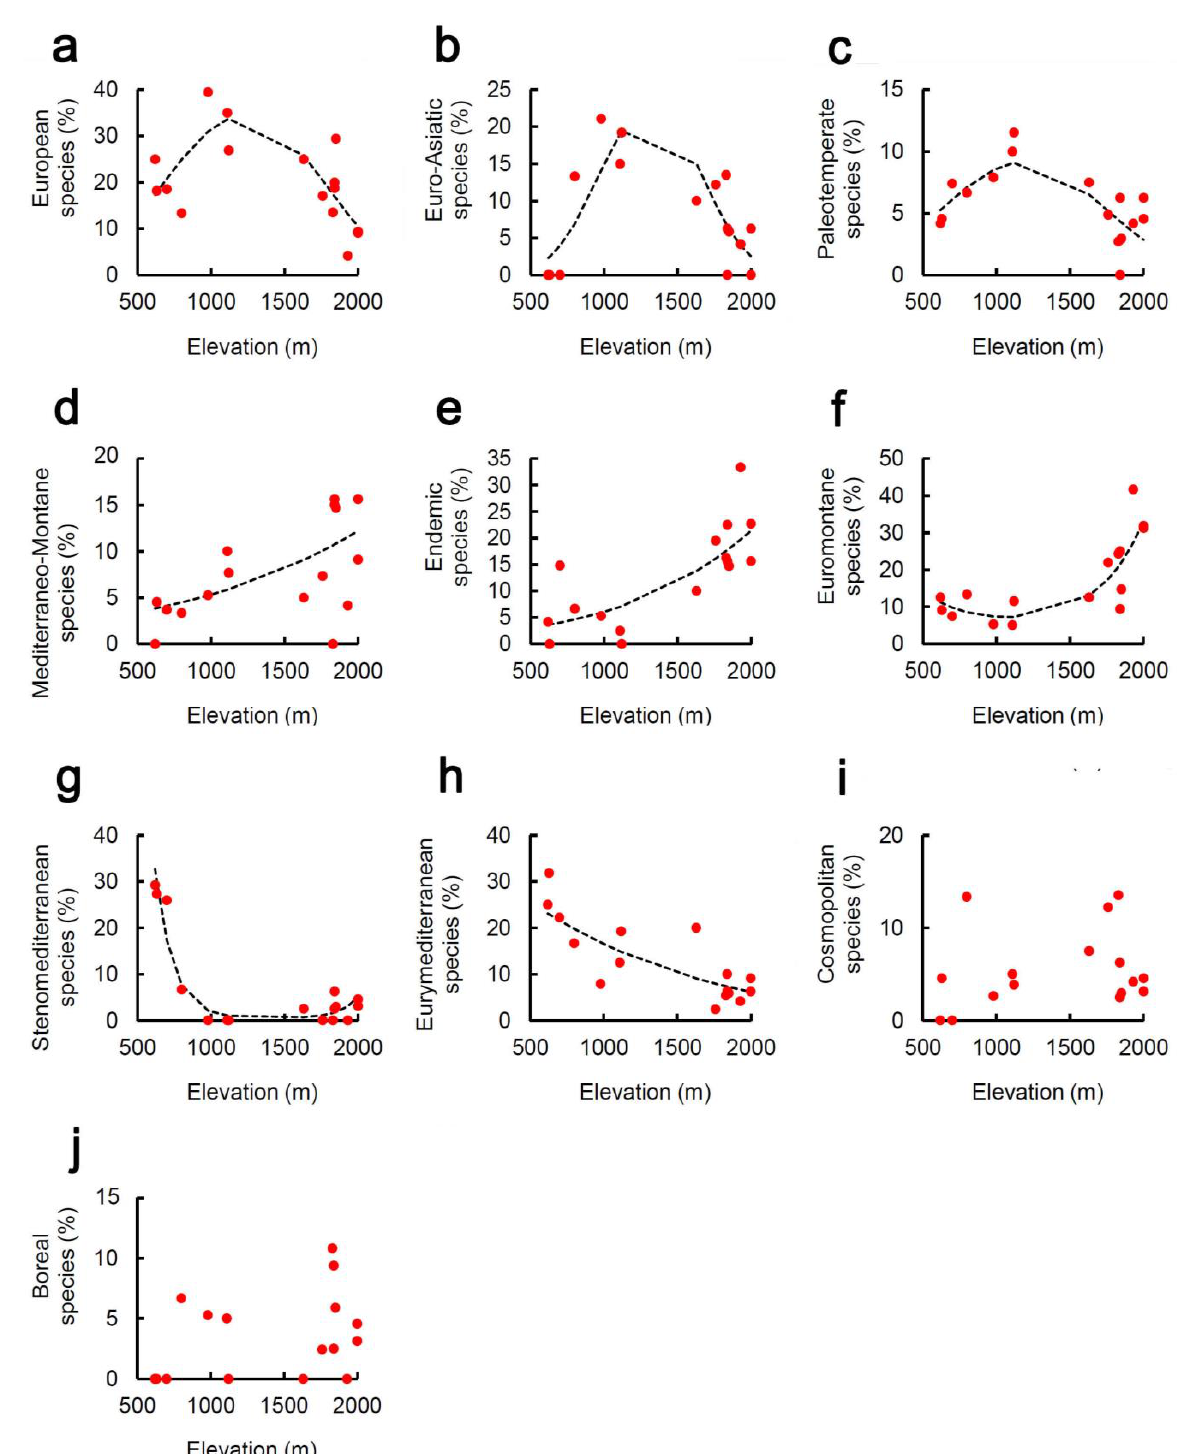
Table 1). Proportion of Cosmopolitan (Figure 3i) and Boreal (Figure 3j) species did not show any pattern.